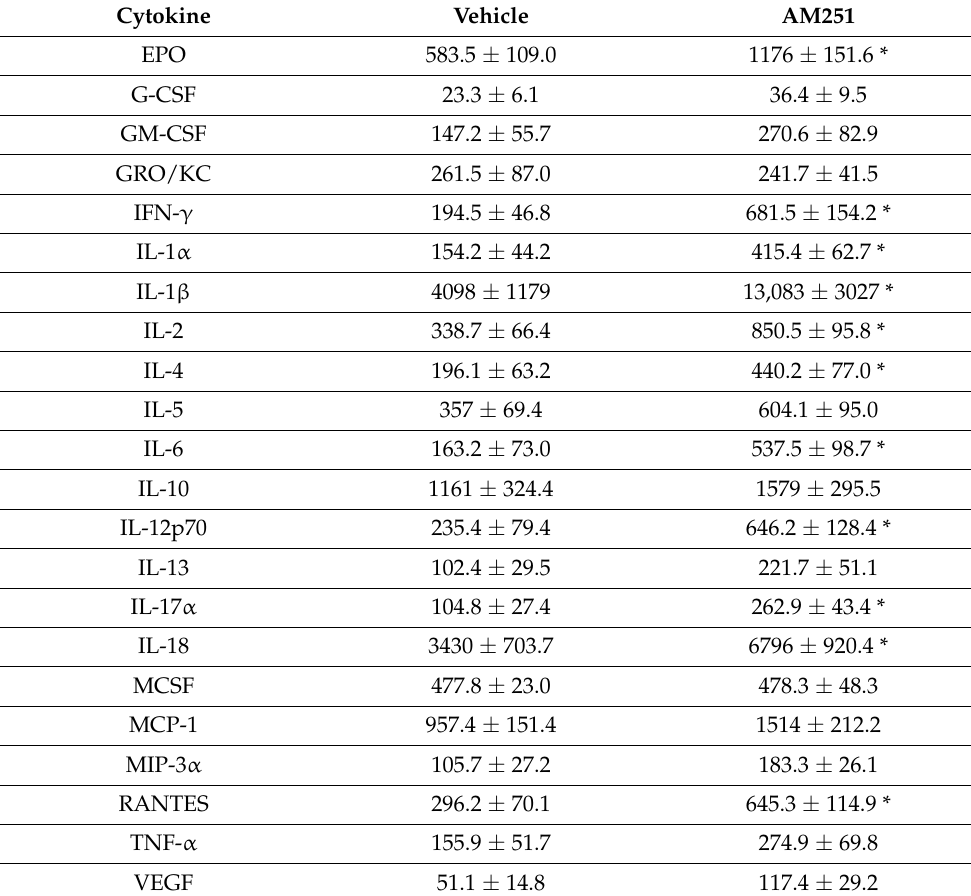
Table 2. Plasma cytokine levels following AM251 treatment in HFD rats. HFD rats were injected daily with either AM251 (3 mg/kg of body weight, ip) or vehicle for six weeks. All results are presented as a mean ± SEM from n = 6–9 (AM251) or n = 5–10 (vehicle) treated rats on an HFD in % concentration within range (ng/L). Significance * p ≤ 0.05 compared to vehicle. Cytokine Vehicle AM251 EPO 583.5 ± 109.0 1176 ± 151.6 * G-CSF 23.3 ± 6.1 36.4 ± 9.5 GM-CSF 147.2 ± 55.7 270.6 ± 82.9 261.5 ±